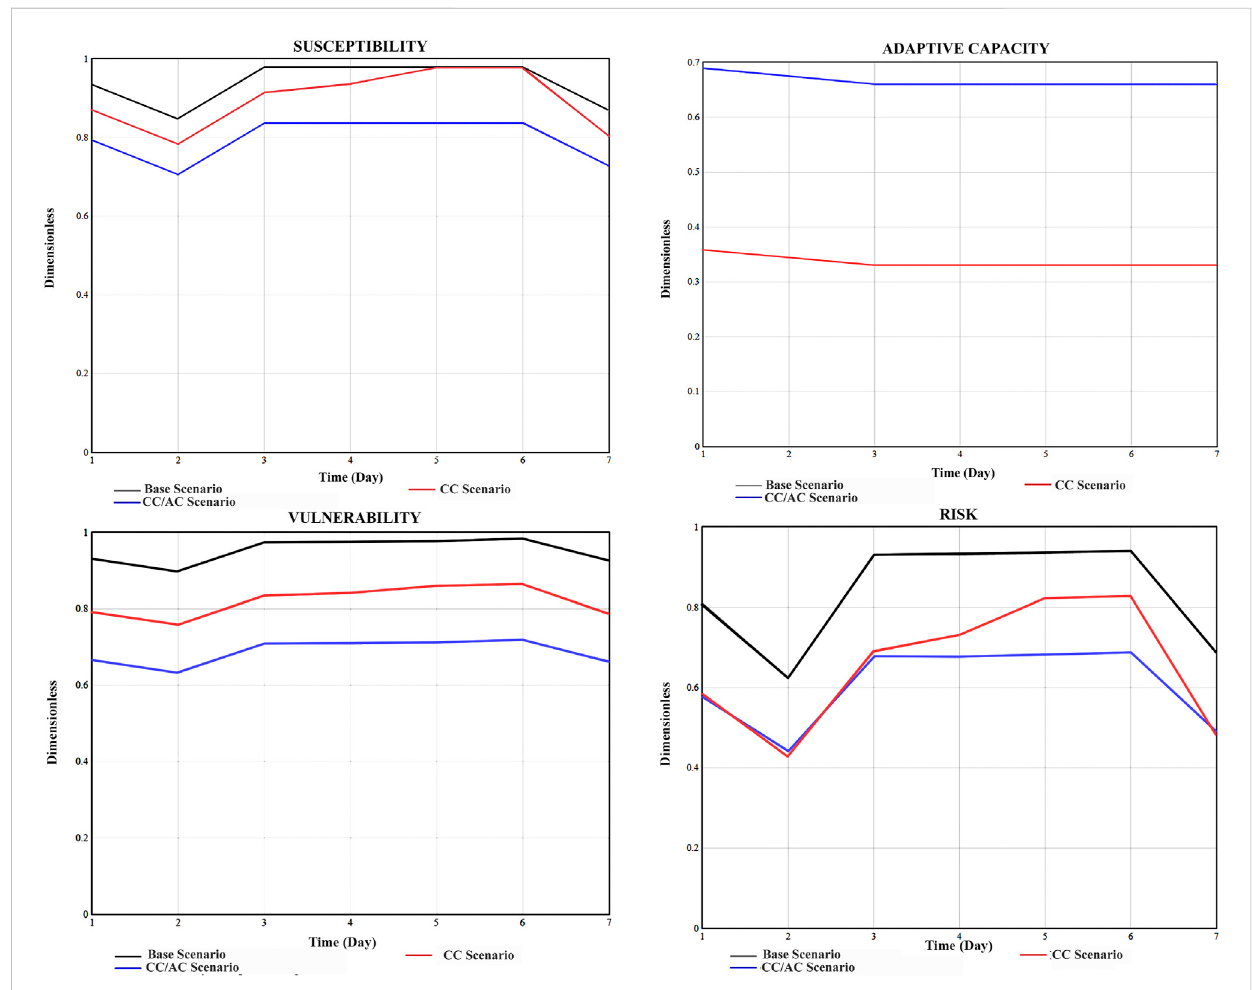
FIGURE 10 Results of the three examined scenarios for susceptibility, adaptive capacity, vulnerability, and related risks.